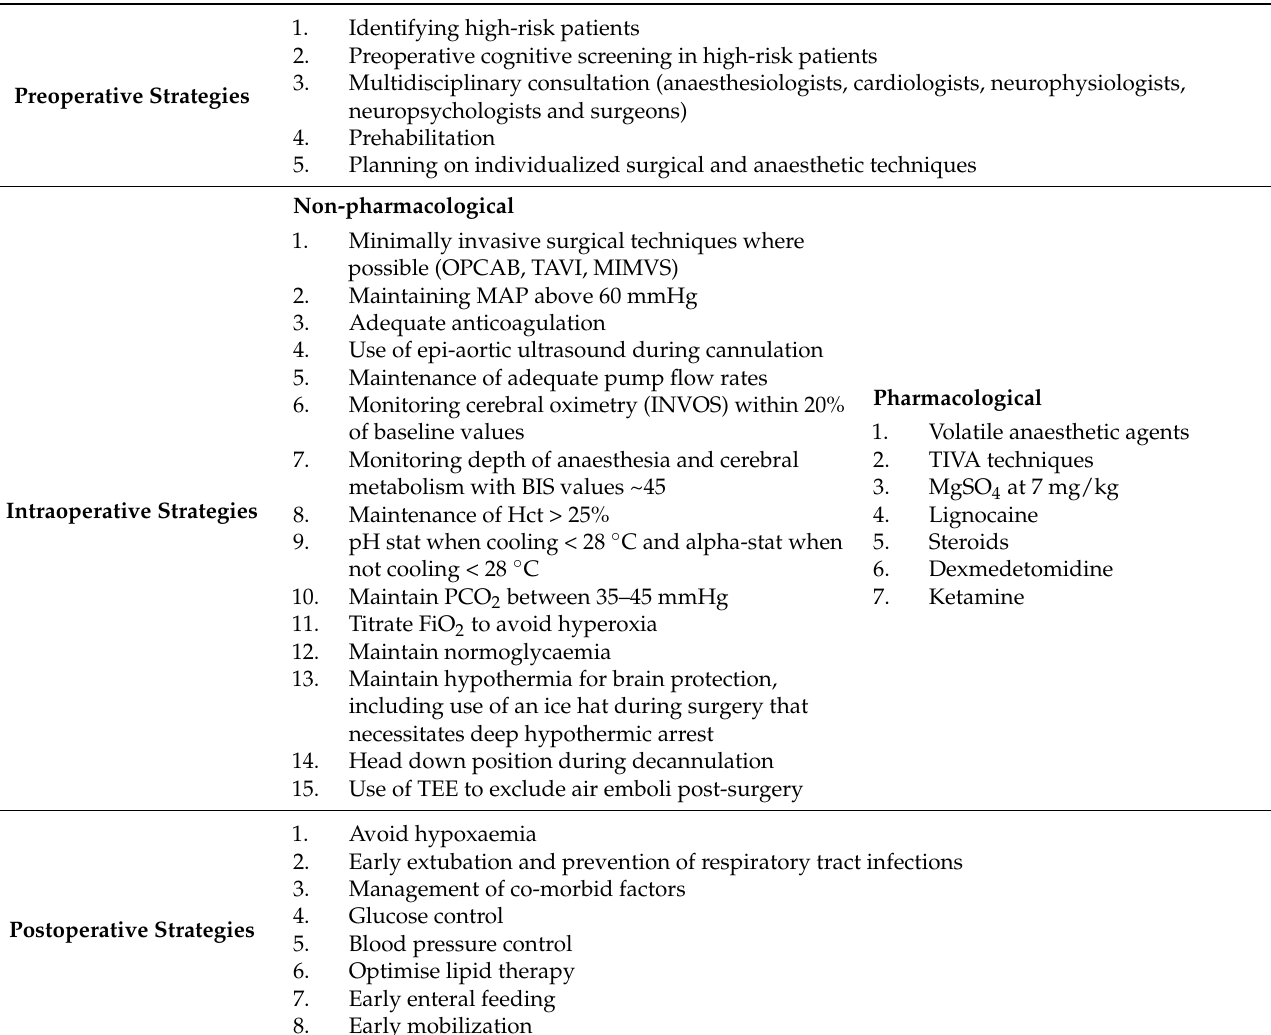
Table 2. Neuroprotection strategies for patients undergoing cardiac